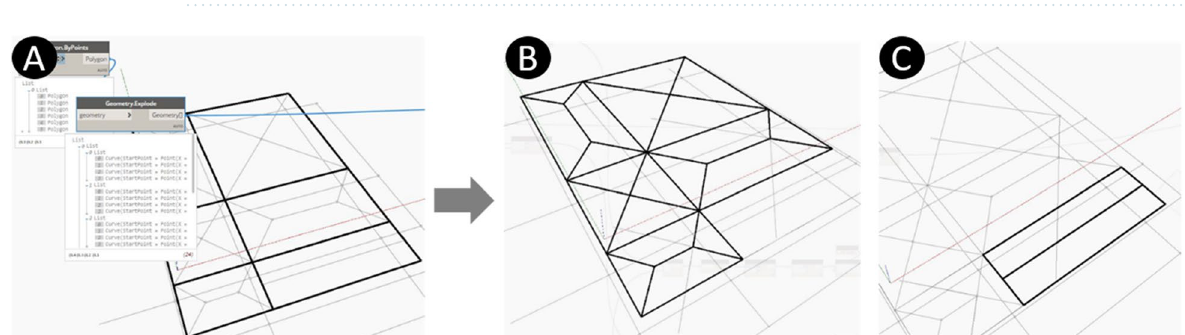
Figure 7. The developed Dynamo custom nodes for ( A ) solid slab, ( B ) flat slab design, ( C ) flat slab punching check.